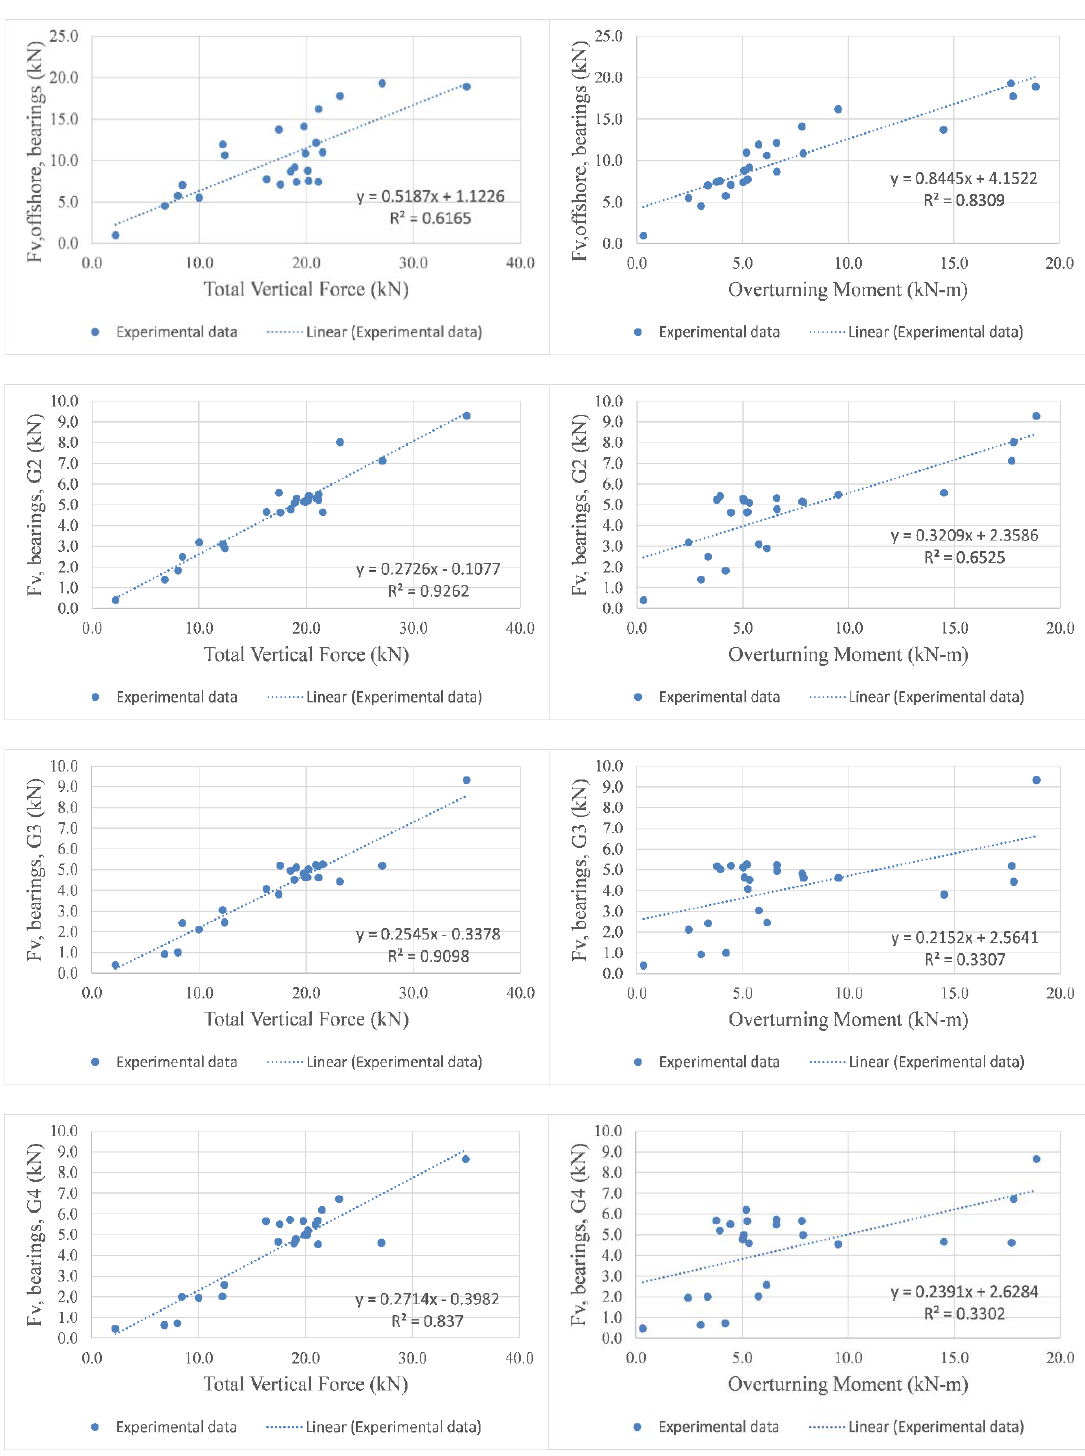
Figure 14. Measured maximum uplift in individual bearings as a function of maximum total uplift ( left ) and overturning moment ( right ).